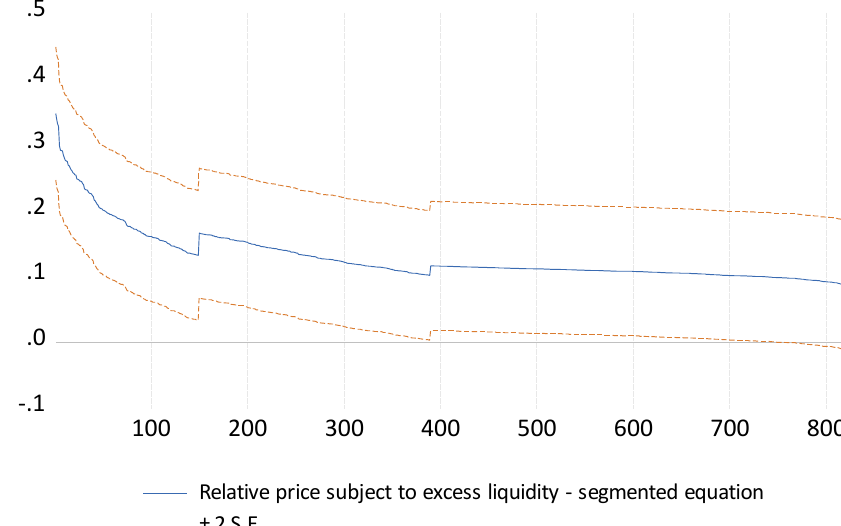
Figure 3. The segmented liquidity demand function of the Hungarian banking system